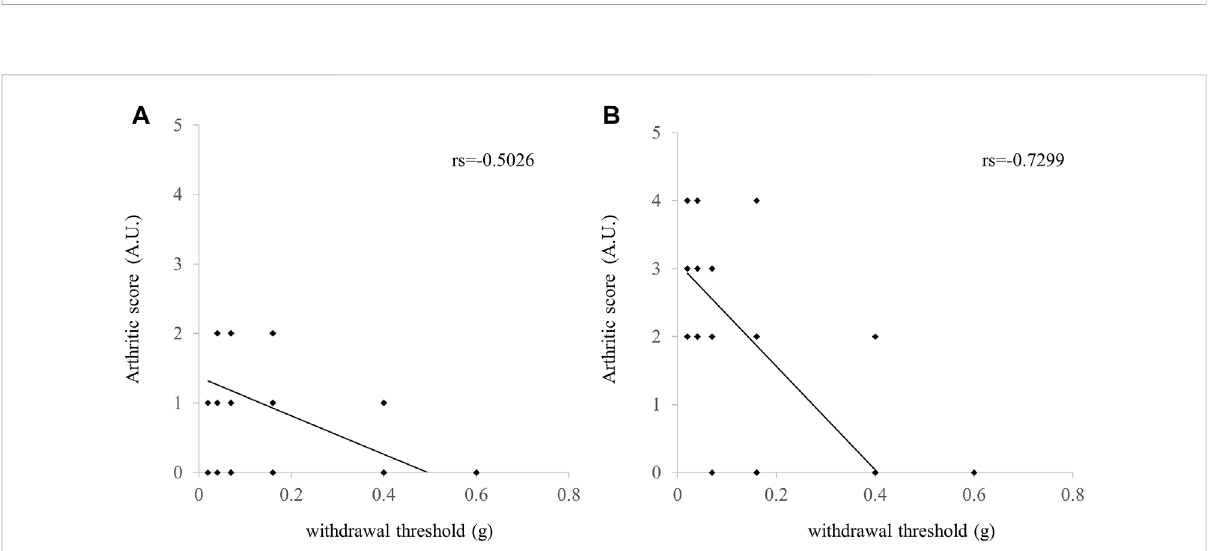
FIGURE 3 Correlation of arthritic score with mechanical allodynia. (A) First week. (B) Fourth week for the second antigen administration (Number of legs; total 56). Pearson ’ s correlation coef fi cient was used for the statistical analyses. p < 0.05 was considered statistically signi fi